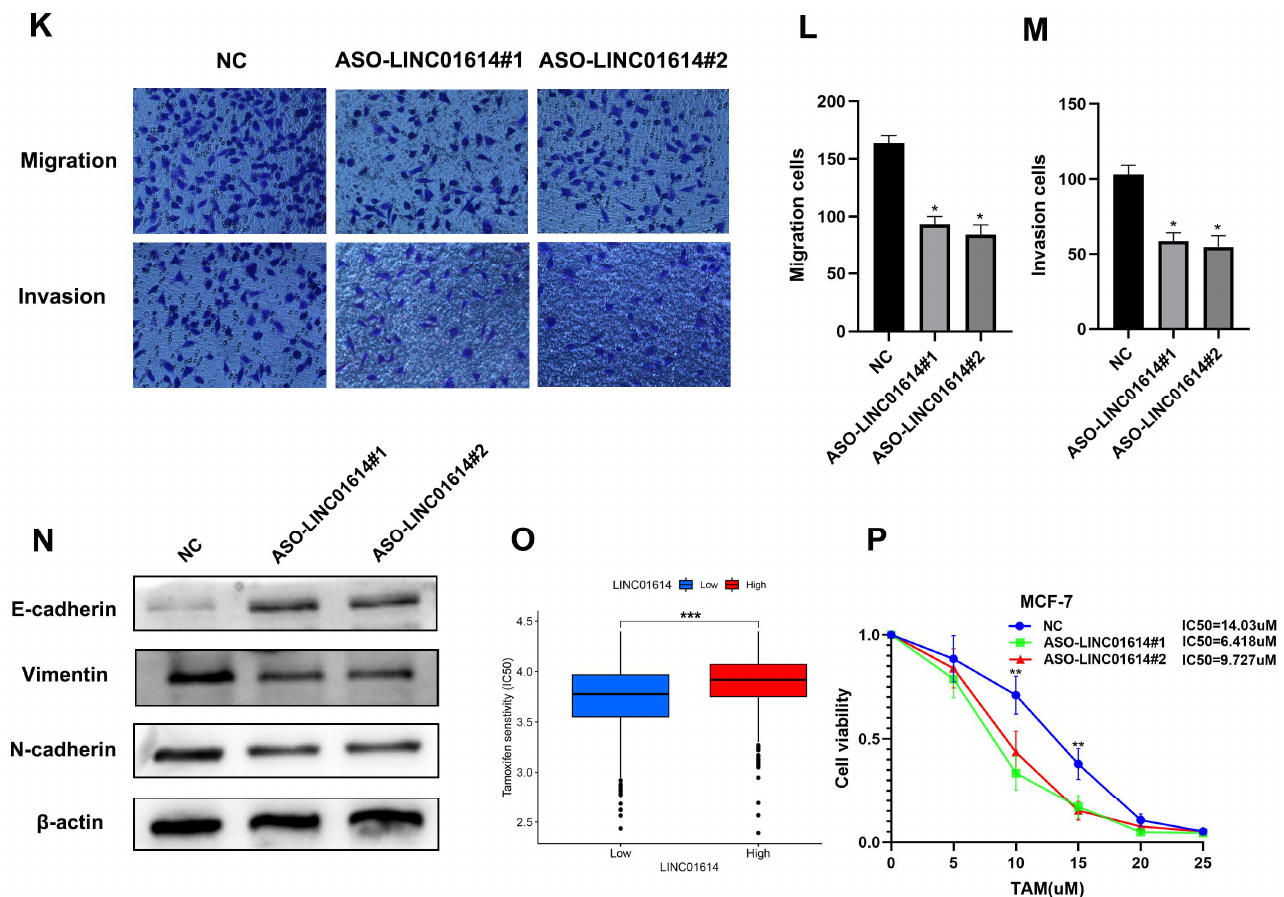
Figure 9. LINC01614 functional enrichment and in vitro experiments. ( A ) Expression of LINC01614 in the TCGA-BRCA dataset. ( B ) High expression of LINC01614 predicts poor prognosis in BC patients. ( C ) Expression of LINC01614 in cancerous and paracancerous tissues of BC patients. ( D – G ) Gene set enrichment analysis of LINC01614. ( H ) Expression of LINC01614 in breast cancer cell lines.